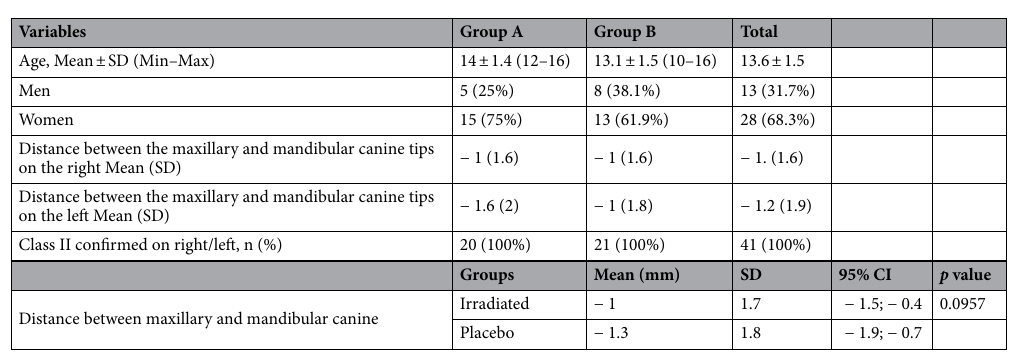
Table 1. Patient characteristics and mean distances between the maxillary and mandibular canine tips in the irradiated and placebo groups at baseline. mm millimeters, SD standard deviation, 95% CI 95% confidence interval; significant at p <